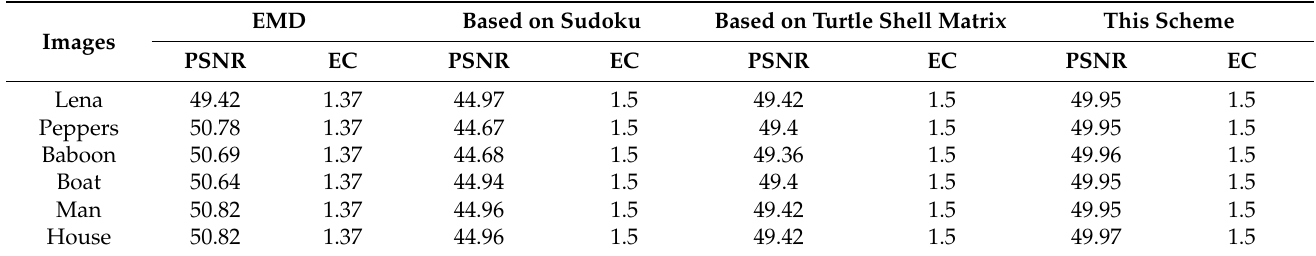
Table 4. Comparison of evaluation metrics in different image coding concealment. Based on Sudoku Based on Turtle Shell Matrix